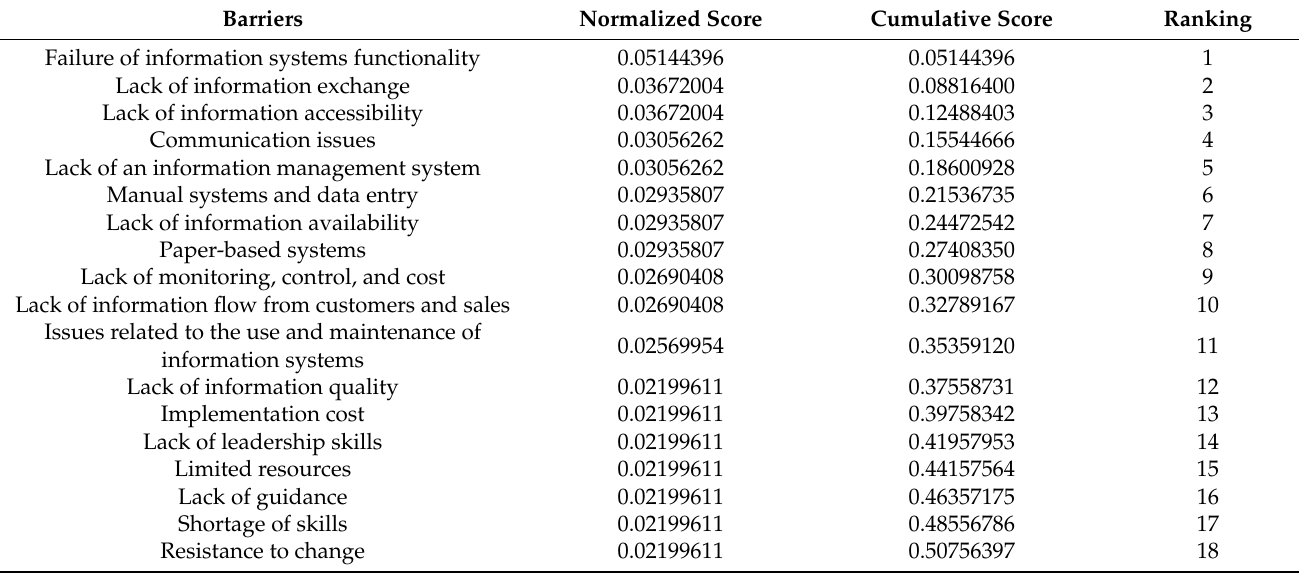
Table 3. Assessed barriers to information management.